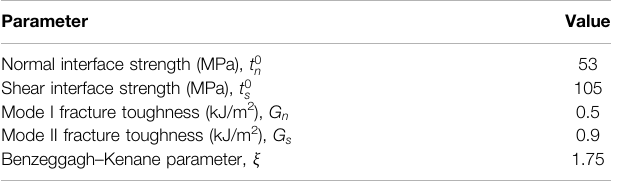
TABLE 1 | Interfacial properties for SiC matrix composites (Choi and Kowalik, 2008; Liu et al., 2016). Parameter